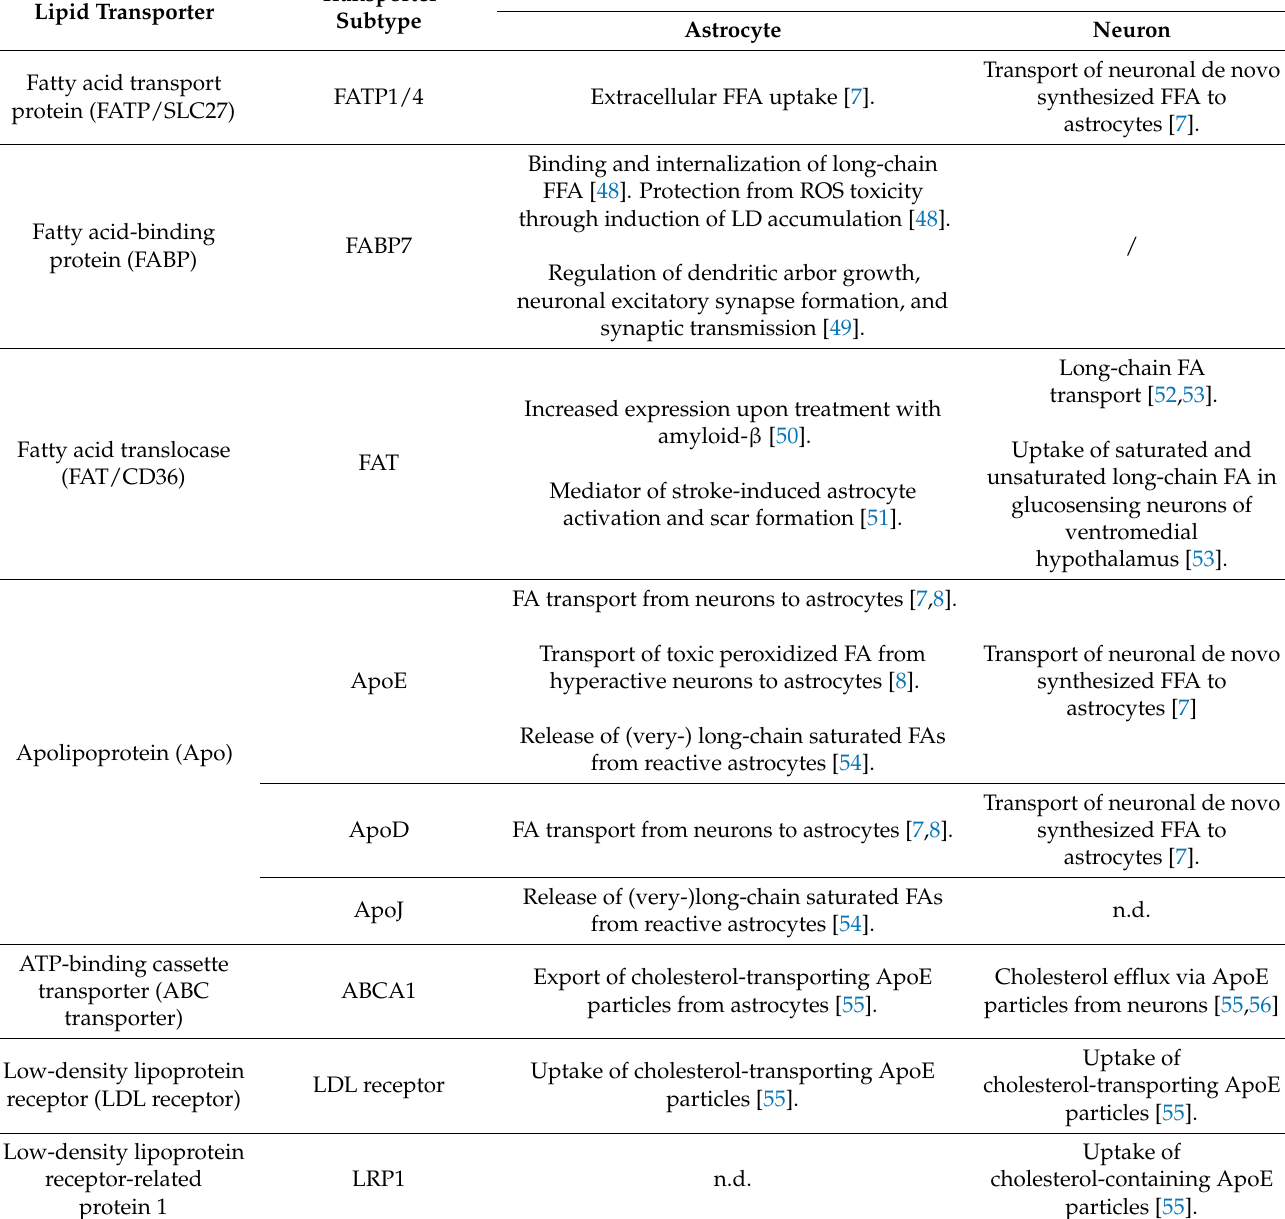
Table 1. Lipid transporters in astrocytes and neurons and their